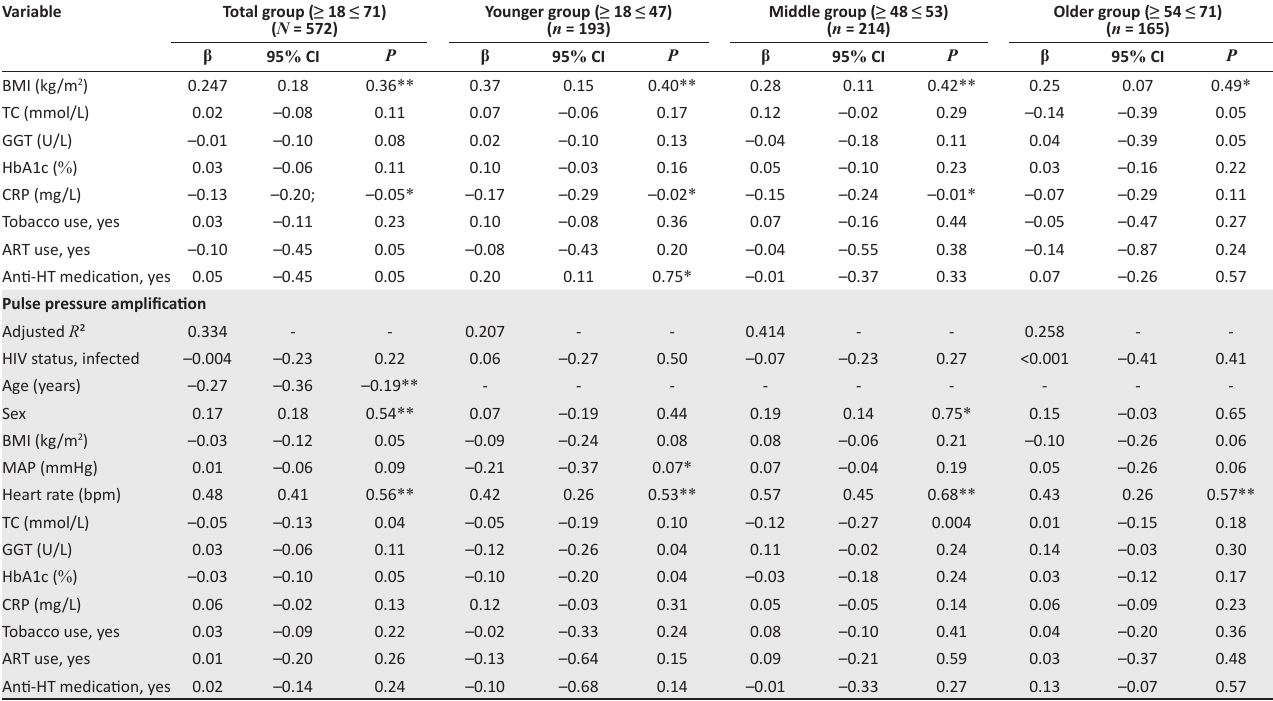
TABLE 2-A1 (Continues...): Multiple regression analyses between vascular measures and HIV status in the total group and in different age tertile groups.